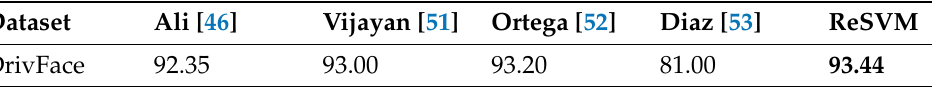
Table 9. Comparison using DrivFace